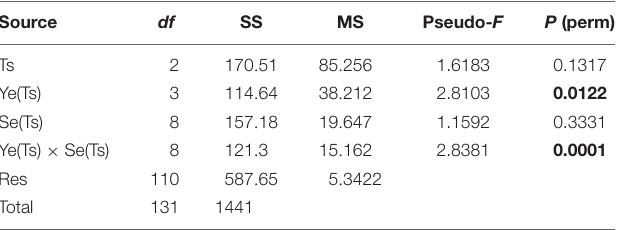
TABLE 4 | Results of PERMANOVA analyses for the trophic variables considering the factors Trophic status phase (Ts), Year (Ye), and Season (Se).